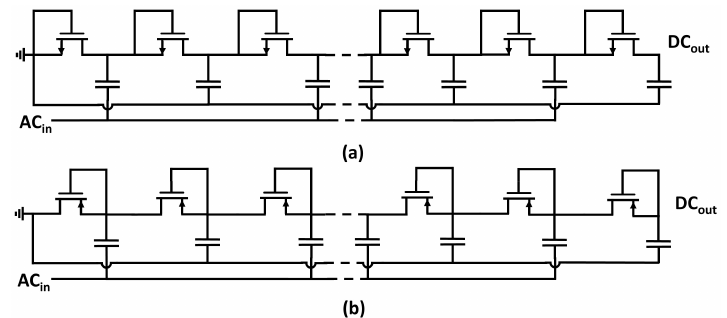
Figure 3. Circuit diagram of ( a ) NMOS and ( b ) PMOS implementations of a multi-stage Dickson voltage multiplier in the case of a single power